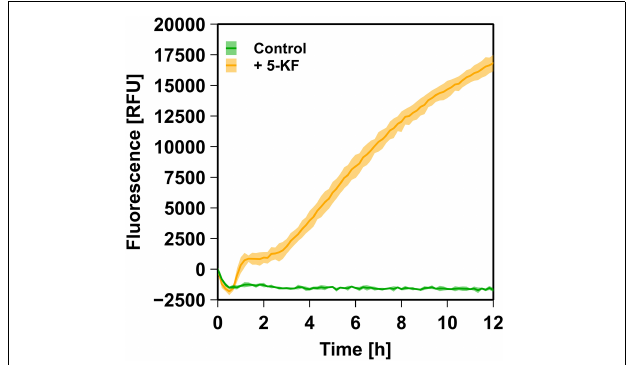
FIGURE 7 | Relative fluorescence units (RFUs) detected in assays containing 5-KF, ammonium chloride, and phosphate. Using 80 mM ammonium chloride, 80 mM phosphate, and 6.45 mM 5-KF fluorescence was measured using an excitation wavelength of 365 nm and an emission wavelength of 445 nm (orange line). In control assays, 5-KF was substituted with H 2 O demin (green line). Incubation of the biological triplicates at 37 ◦ C and simultaneous measurement was achieved using an Infinite M Plex plate reader (Tecan AG Group). The dark, central line of the data shown reflects the mean of each biological triplicate, while the lighter area above and below indicates the standard